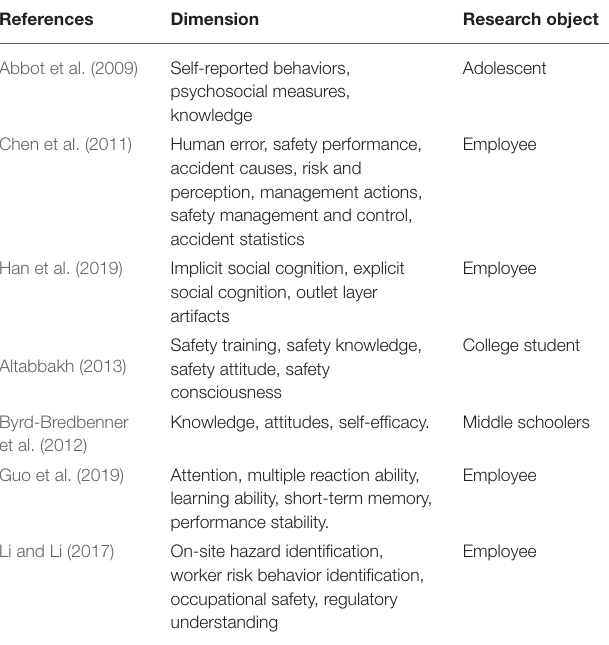
TABLE 1 | Safety cognition capability